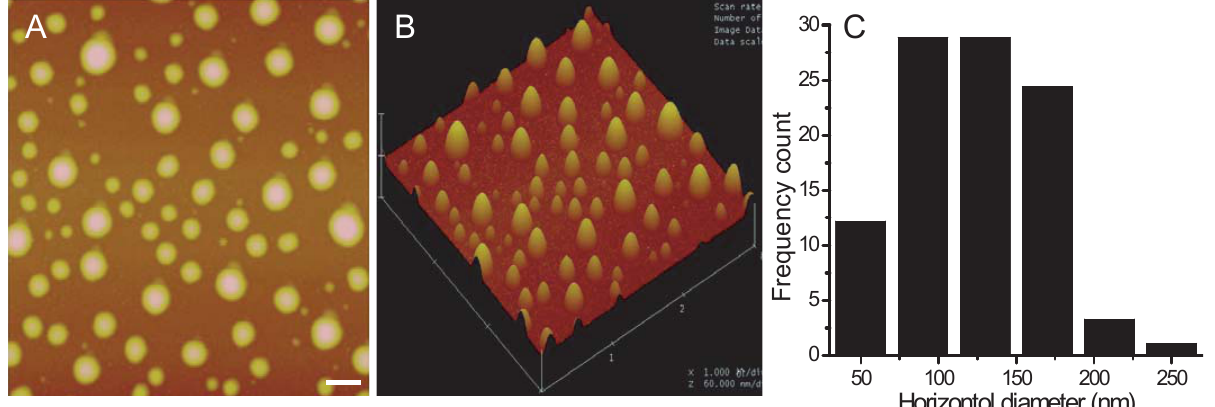
Figure 5. Aggregates of tau incubated in 0.1% formaldehyde for 15 days. The experimental conditions were described in Figure 3, except that the incubation time was prolonged to 15 days. A typical AFM image of tau in the presence of formaldehyde is present in A (Bar: 100 nm), together with a three dimensional image ( B ) for a better visual effect. Frequency counts of horizontal diameters of particles are presented in C .